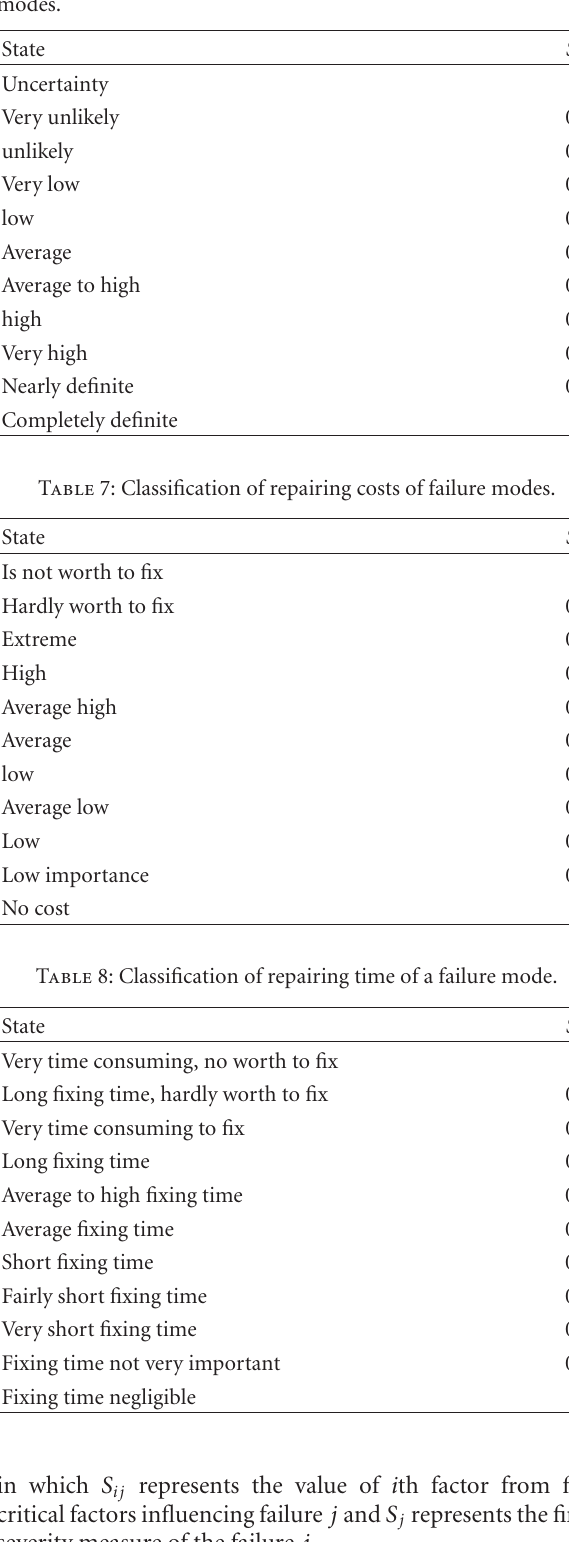
Table 4: Classification of safety severity of each failure mode.